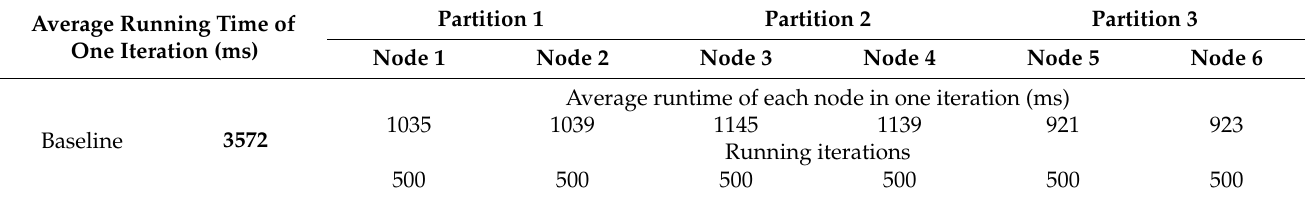
Table 5. Distributed training baseline.